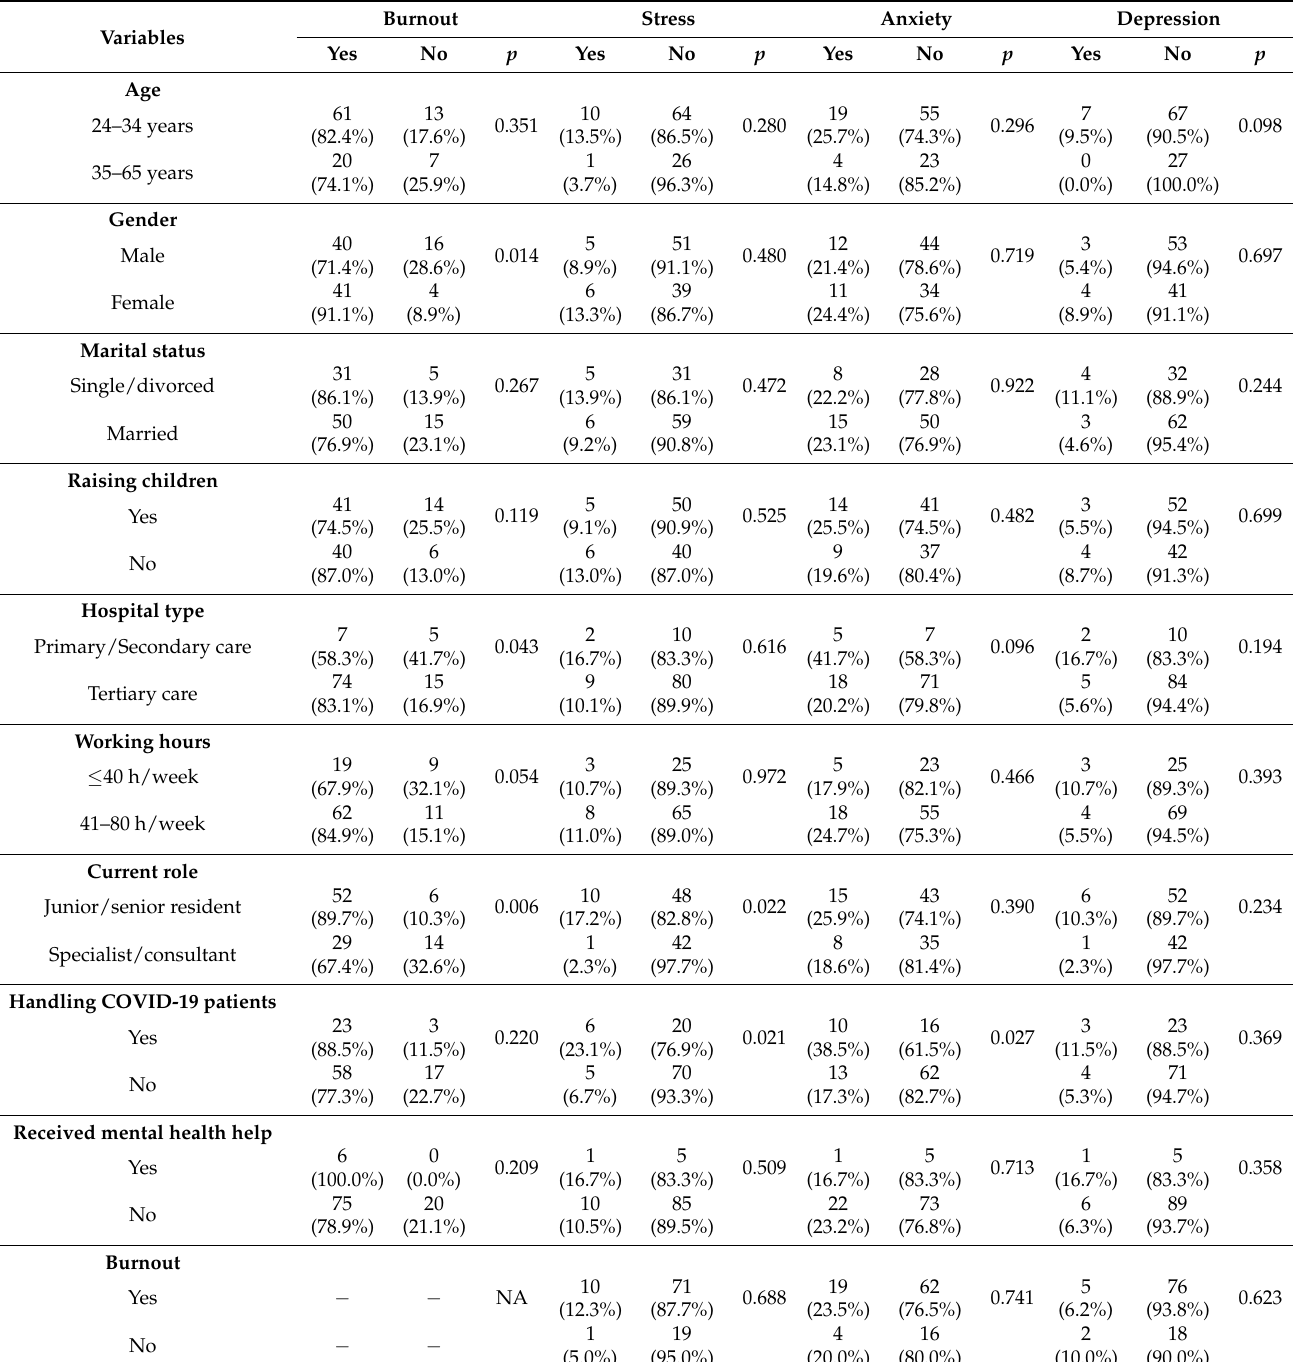
Table 5. Association between sociodemographic variables and each of burnout, stress, anxiety, and depression ( n = 101).